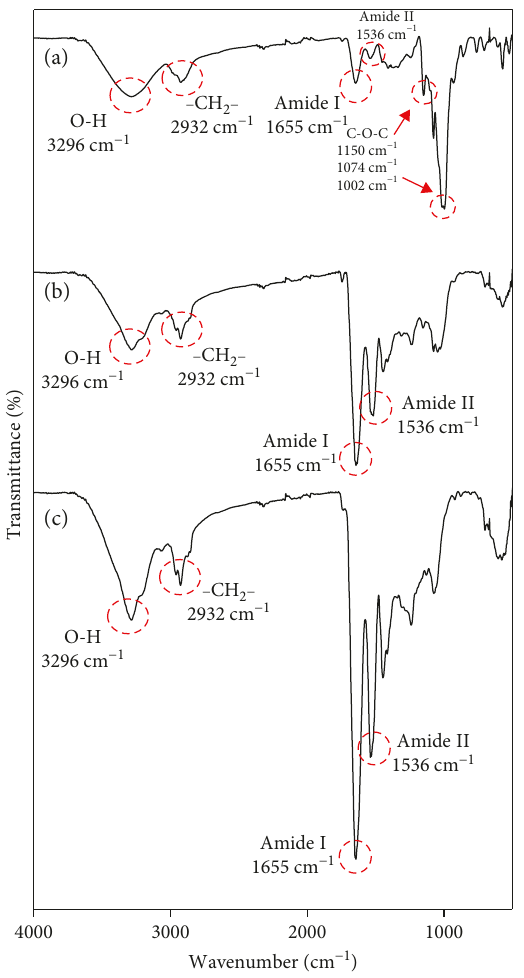
Figure 5: Fourier transform infrared (FTIR) spectrum of (a) wheat fl our, (b) wheat gluten, and (c) wheat-gluten proteins soluble in ethanol (WGPSE) (gliadins, mainly).